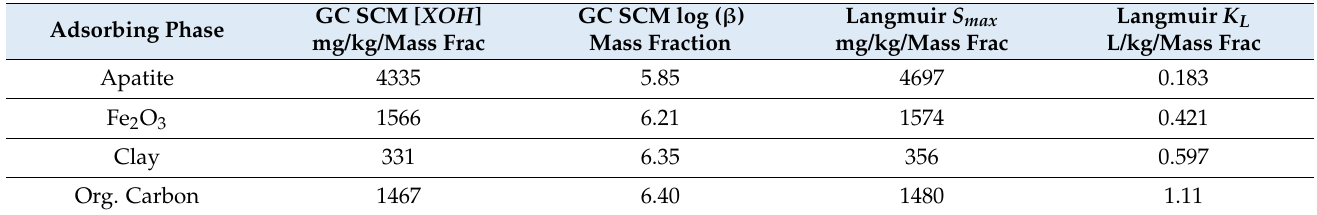
Table 5. Estimated phase contributions to Langmuir isotherm parameters S max and K L and GC SCM parameters [ XOH ] and log ( β ) per unit mass fraction of phase